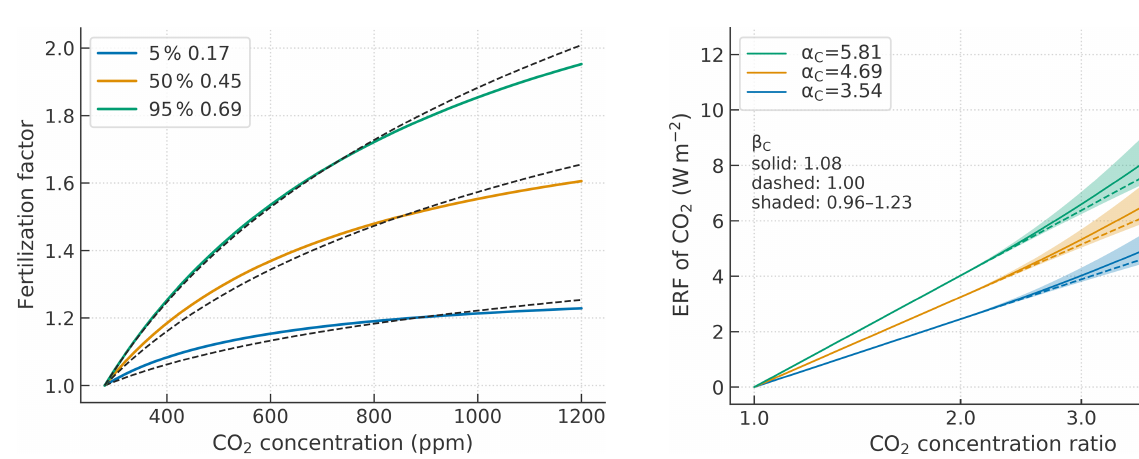
Figure 7. CO 2 fertilization factor as a function of atmospheric CO 2 concentration with different control parameters ( ˆ β L ) of 0.17, 0.45, and 0.69, corresponding to the 5th, 50th, and 95th percentiles of the Prior ensemble described in Sect. 3.1. The colored lines show sigmoid curves used in the MCE model, and the black dashed lines show reference logarithmic curves.